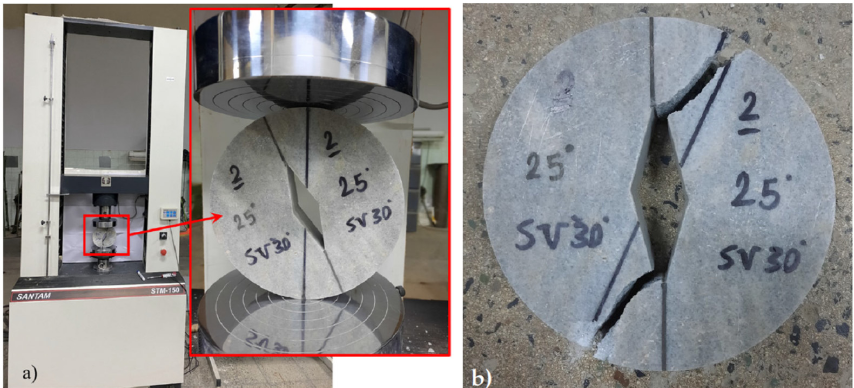
Figure 3. SVNBD sample with 2 α = 30° under pure mode II loading; ( a ) inside the test machine; ( b ) after fracture. ( b ) after